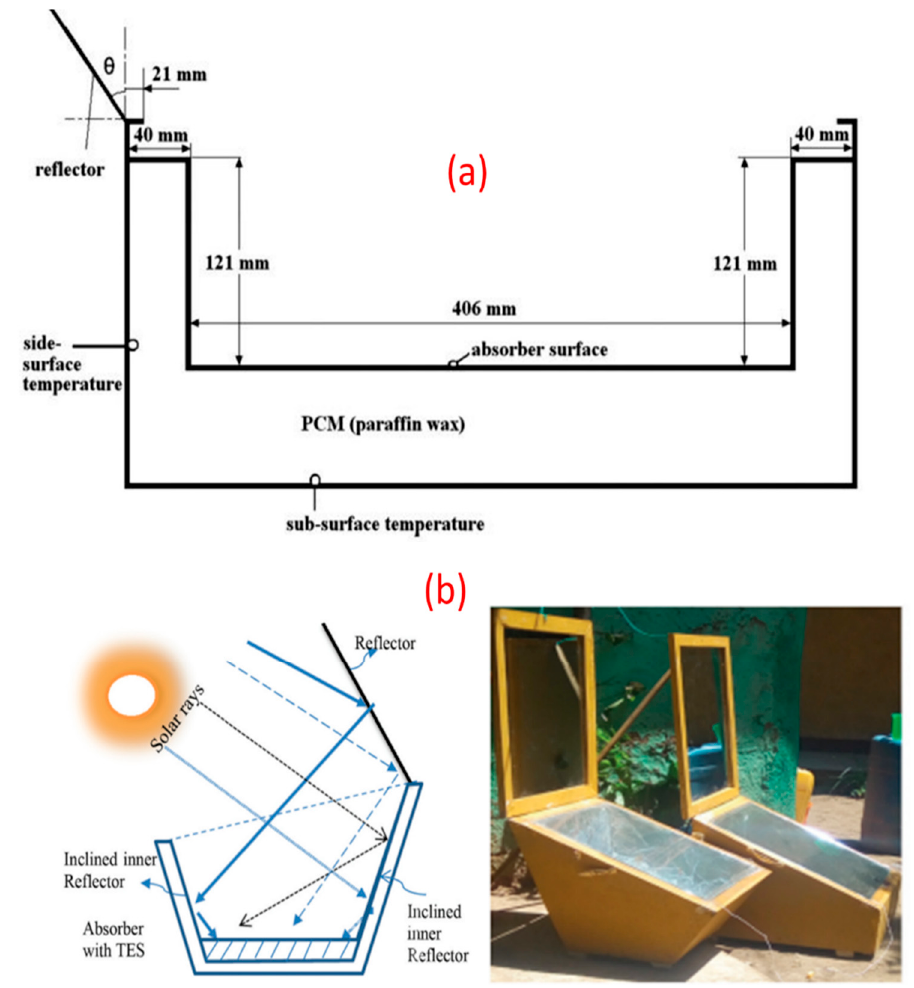
Figure 23. ( a ) Schematic diagram; ( b ) Experiment setup of box-type SC. Reprinted/adapted with